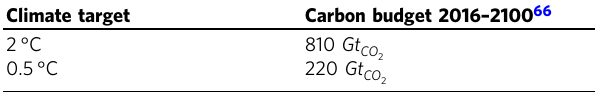
Table 3 Carbon budgets imposed, 66%